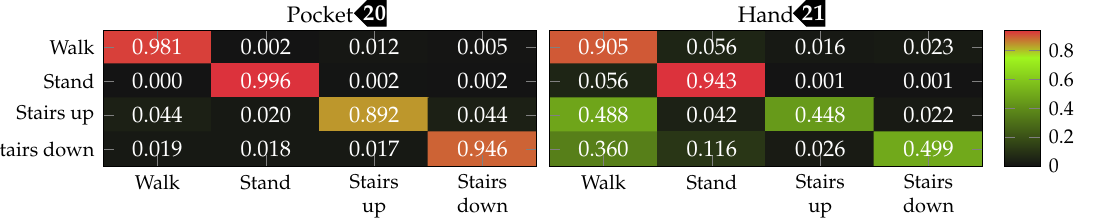
Figure 26. Final confusion matrices for the best-performing configuration (LDA, 2.5s windows, 5 dimensions, two-channel acceleration) of the statistical features approach, for pocket-case and hand-case using an SVM classifier. Each row represents the actual class, each column the